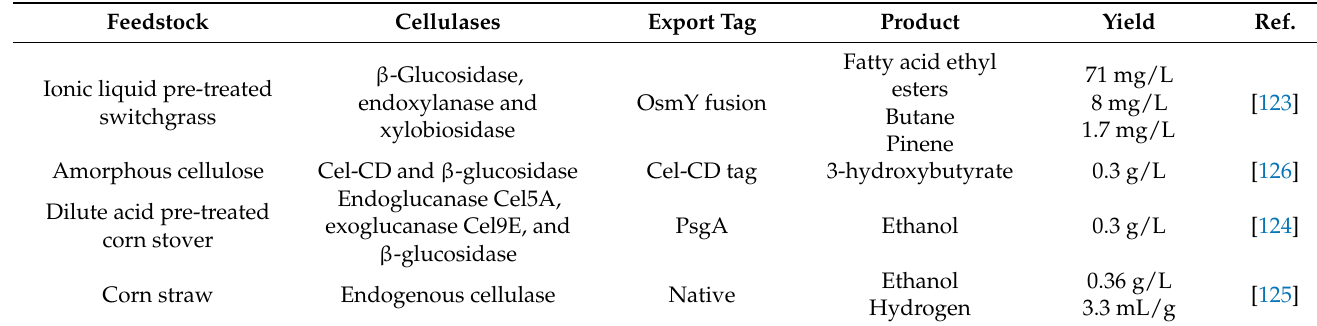
Table 2. Engineered E. coli to facilitate growth on lignocellulose carbon